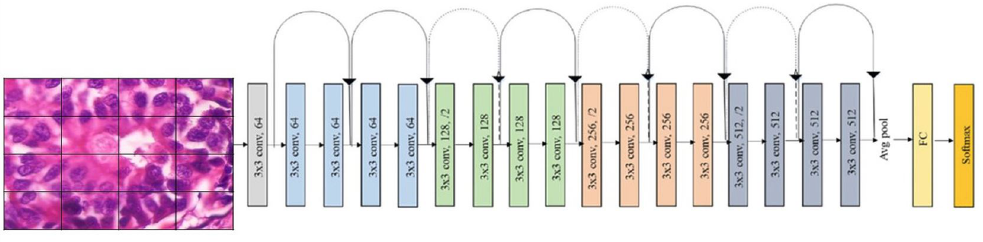
Figure 5. ResNet18 architecture.